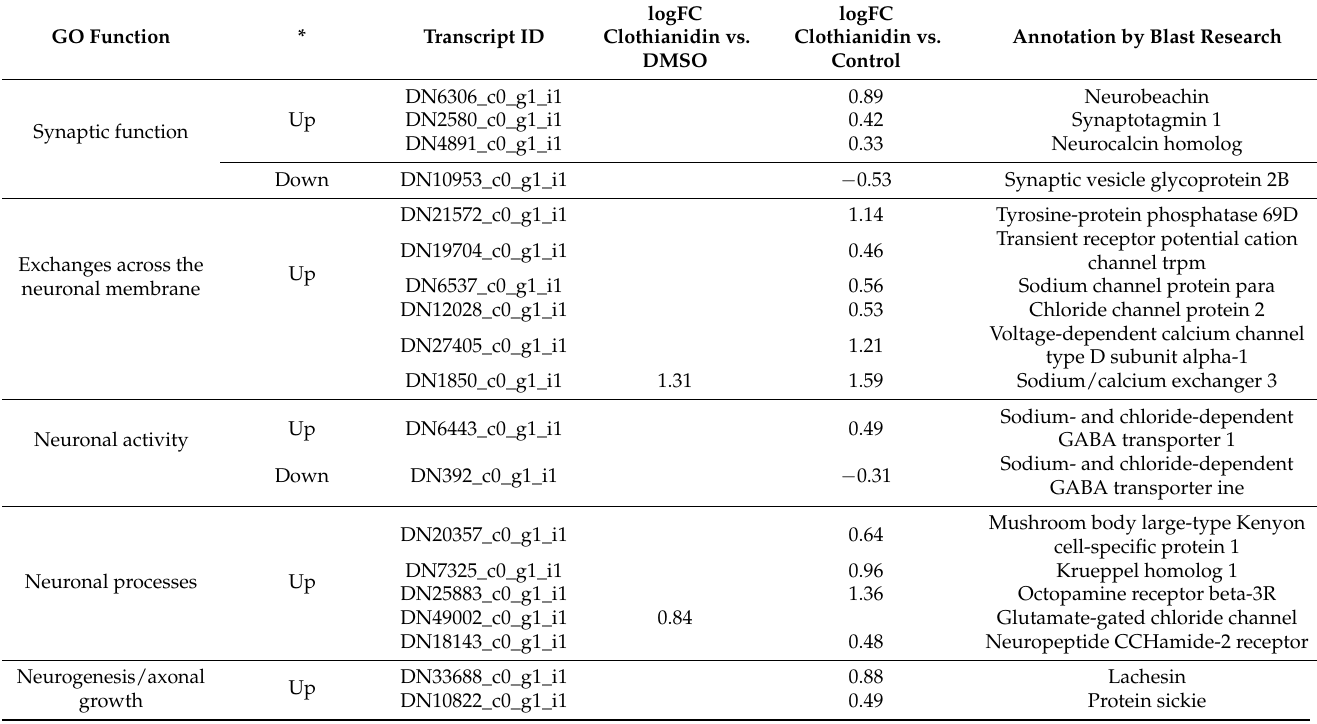
Table 4. Clothianidin exposure affects the transcript abundance of neuronal